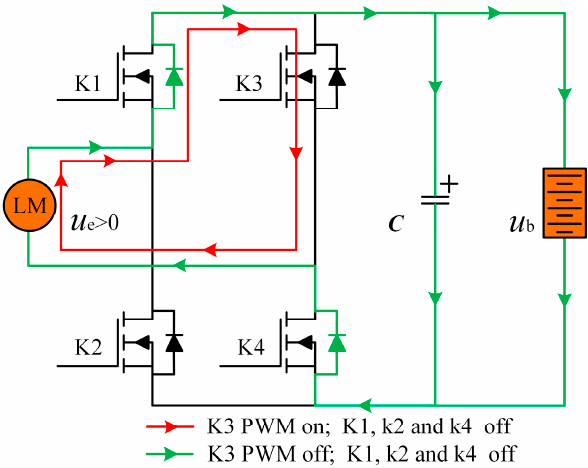
Figure 4. Designed rectifier and its typical current path.